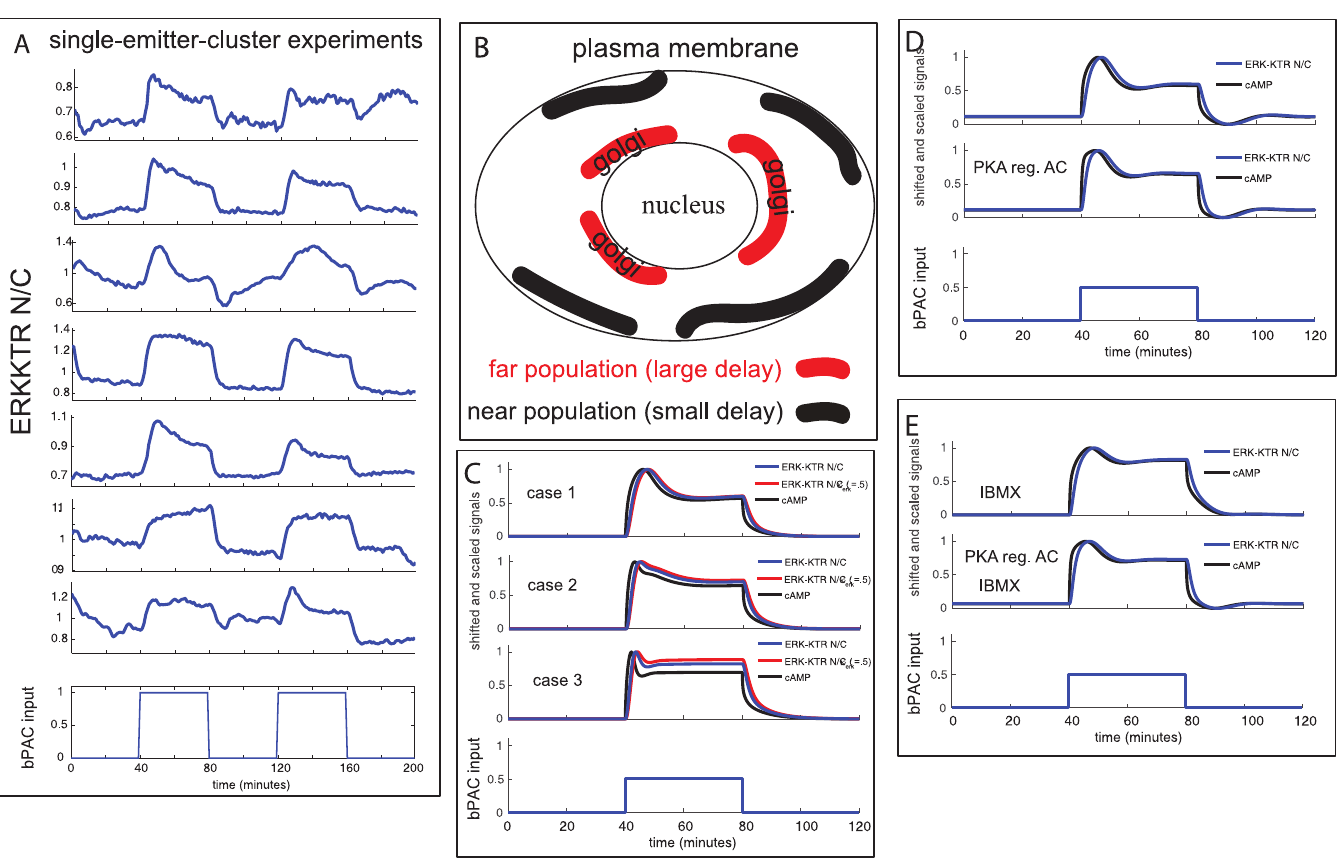
Fig 6. Differences in the emitter ERK-KTR N/C response across bPAC input pulses of the same amplitude reveal the influence of a dynamically changing gap junction state in single-emitter-cluster experiments. (A) Single cell ERK-KTR N/C signals from emitters of different single-emitter-cluster experiments all driven by two-pulse bPAC inputs of the same amplitude. (B) Illustration of the fast gap-junction population (black, near the plasma membrane) and the slow gap-junction population (red, closer to the nucleus). (C) Modeling of gap-junction regulation heterogeneity: Case 1 (far only), Case 2 (near + far), Case 3 (near only). Results are presented for both of the fitted ERK-KTR models ( κ = 1 (blue) and κ = .5 (red, slowest), as was done in Fig 5I). (D) Modeling the undershoot observed in some single erk erk emitters. Top plot: gap-junction regulation only. Middle plot: gap-junction regulation and endogenous adenylyl cyclase feedback. Bottom plot: bPAC input. (E) Modeling the undershoot observed in some single emitters in the presence of PDE inhibitor (IBMX). Top plot: gap-junction regulation only. Middle plot: gap-junction regulation and endogenous adenylyl cyclase feedback. Bottom plot: bPAC input.